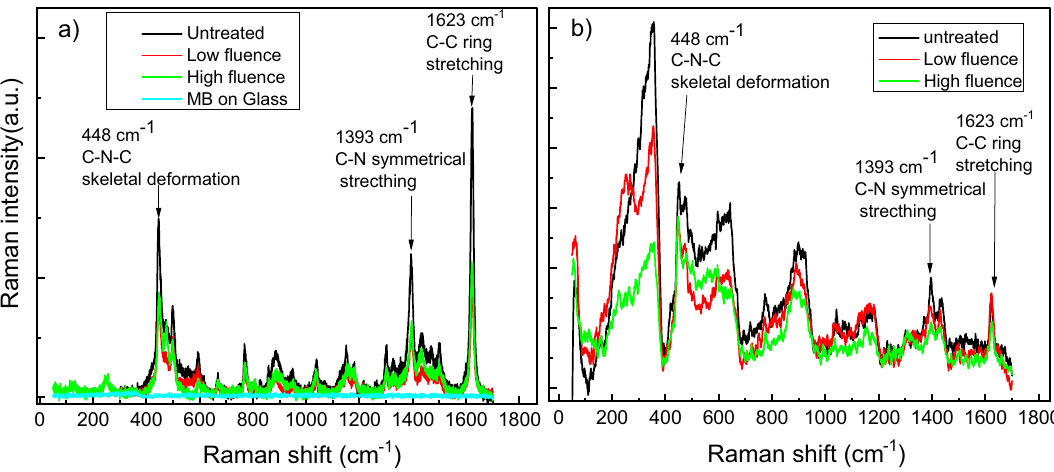
Figure 6. Raman spectra of methylene blue (MB) molecules on porous gold and glass substrate ( a ) and Au/Ag alloys ( b ). For ( a ) the measurements have been performed on glass (blue curve), untreated (black), high fluency region (green), Low fluency region (red). For ( b ) the measurements have been performed on untreated (black), high fluency region (green), Low fluency region